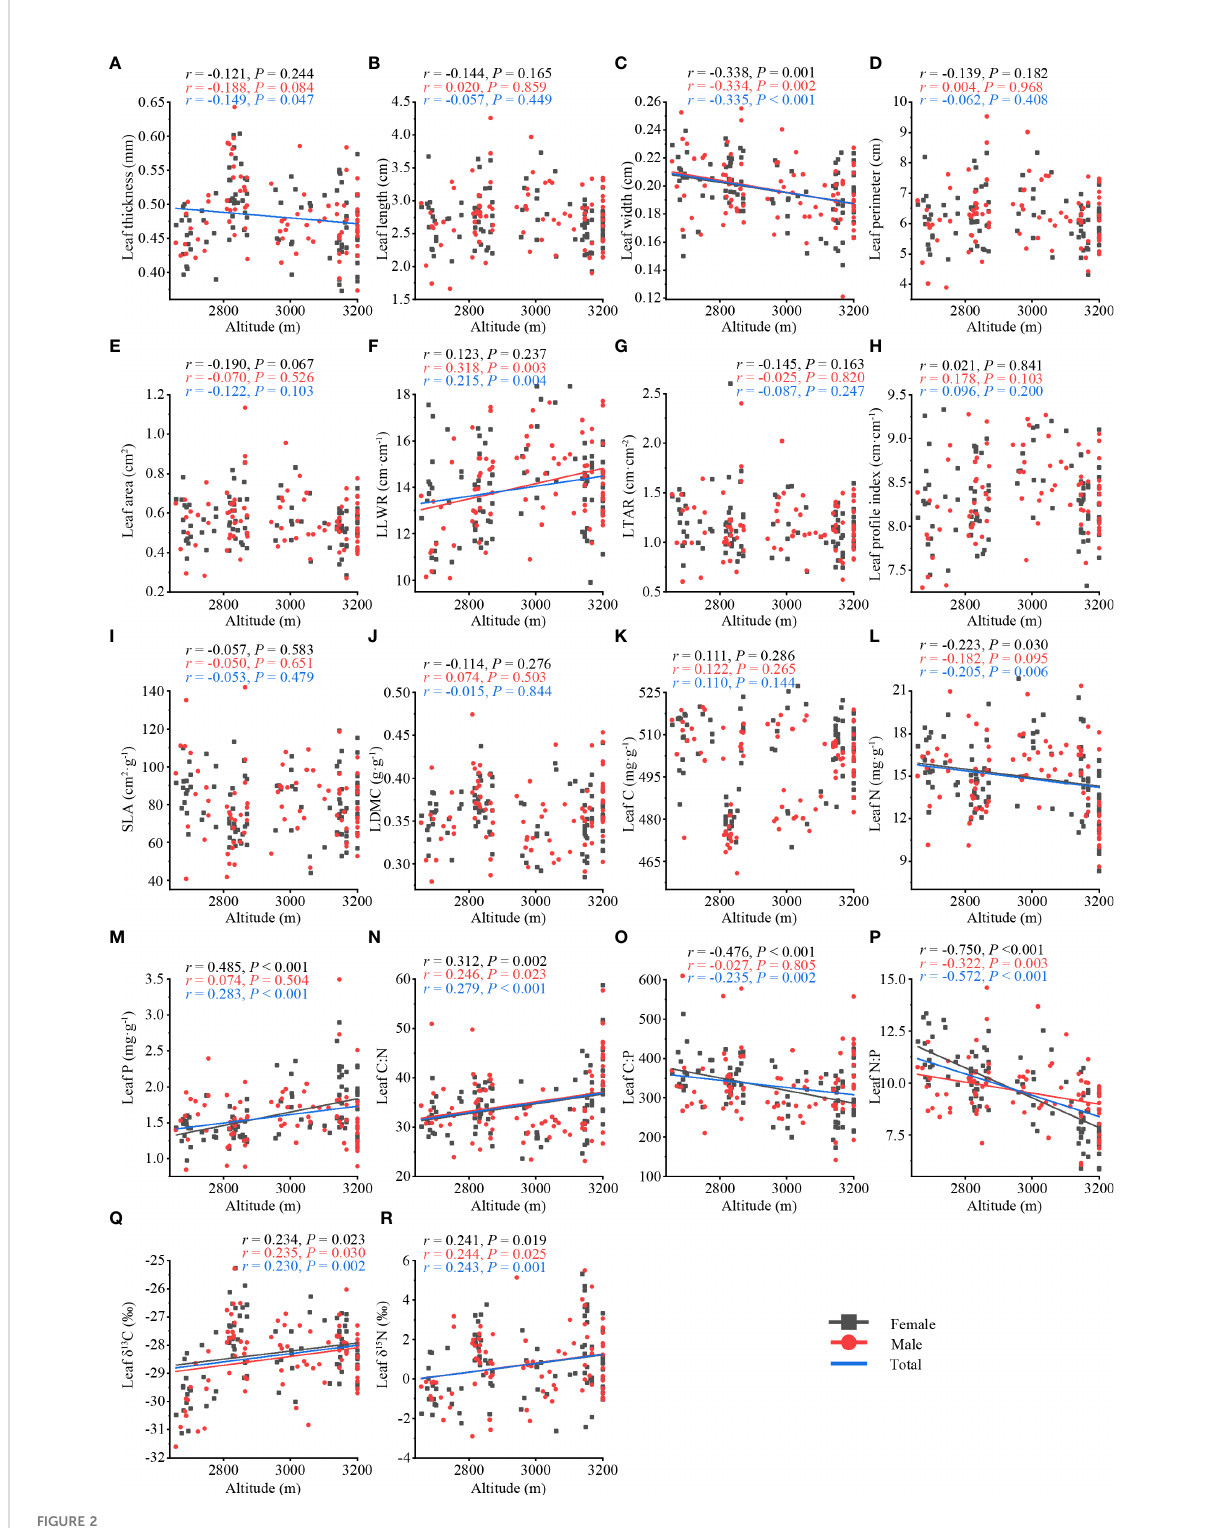
FIGURE 2 Relationship between leaf traits (total, female, male) along altitude in T. fuana . Morphological traits (A – H) , functional traits (I – M) , and stoichiometric traits (N – R) . Regression lines were plotted for signi fi cant relationships with P < 0.05. LLWR, leaf length to width ratio; LTAR, leaf thickness to area ratio; SLA, speci fi c leaf area; LDMC, leaf dry matter content; Leaf C, leaf carbon content; Leaf N, leaf nitrogen content; Leaf P, leaf phosphorus content; Leaf C:N, leaf carbon to nitrogen ratio; Leaf C:P, leaf carbon to phosphorus ratio; Leaf N:P, leaf nitrogen to phosphorus ratio; Leaf d 13 C, leaf carbon isotope ratio; Leaf d 15 N, leaf nitrogen isotope